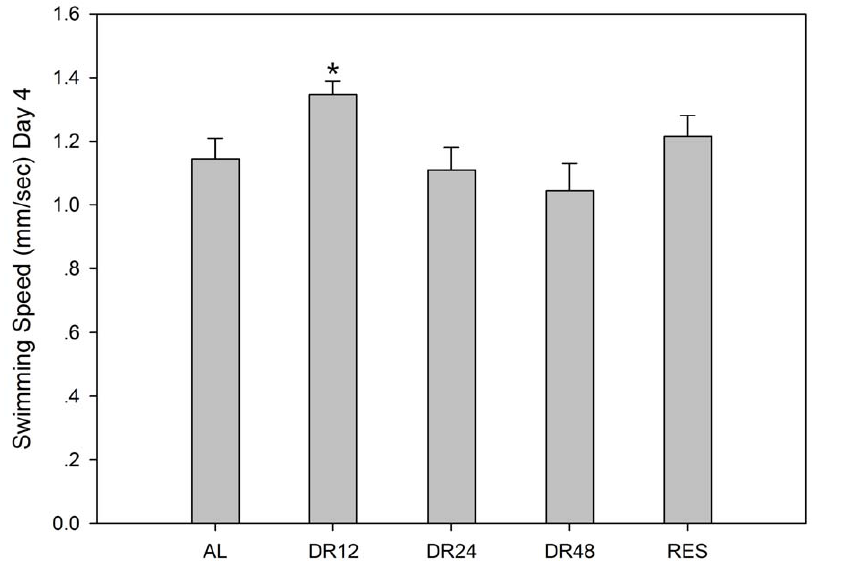
Figure 8. The swimming speed of 4-days-old B.calyciflorus . AL, DR12, DR24 and DR48 represent the rotifer groups starved for 0 h, 12 h, 24 h and 48 h, respectively. Bars represent standard errors. The asterisk indicates significant difference from control. ( * P ,